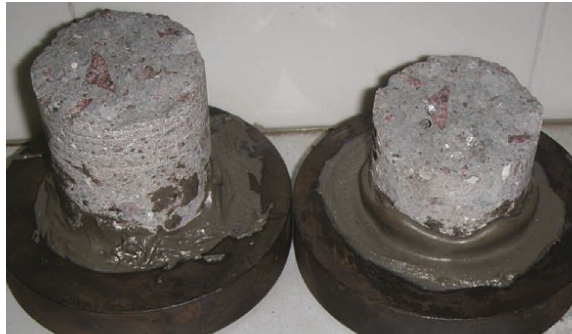
Figure 26: The failure of specimens under dynamic